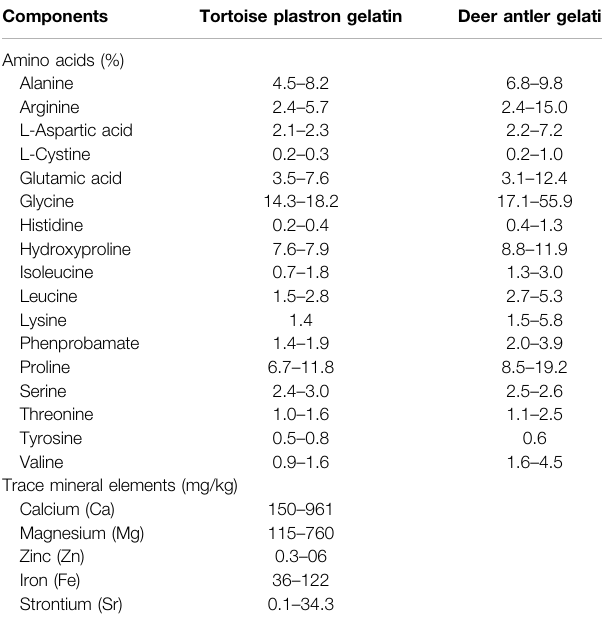
TABLE 1 | Amino acids and trace mineral elements contained in the gelatins a